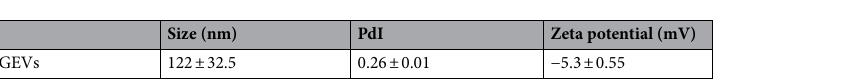
Figure 1. Characterization of grapefruit-derived extracellular vesicles (GEVs). ( a ) Cryogenic transmission electron microscopy (cryo-TEM) images of GEVs. ( b ) Size distribution of GEVs using a tunable resistive pulse- sensing (TRPS) technique.